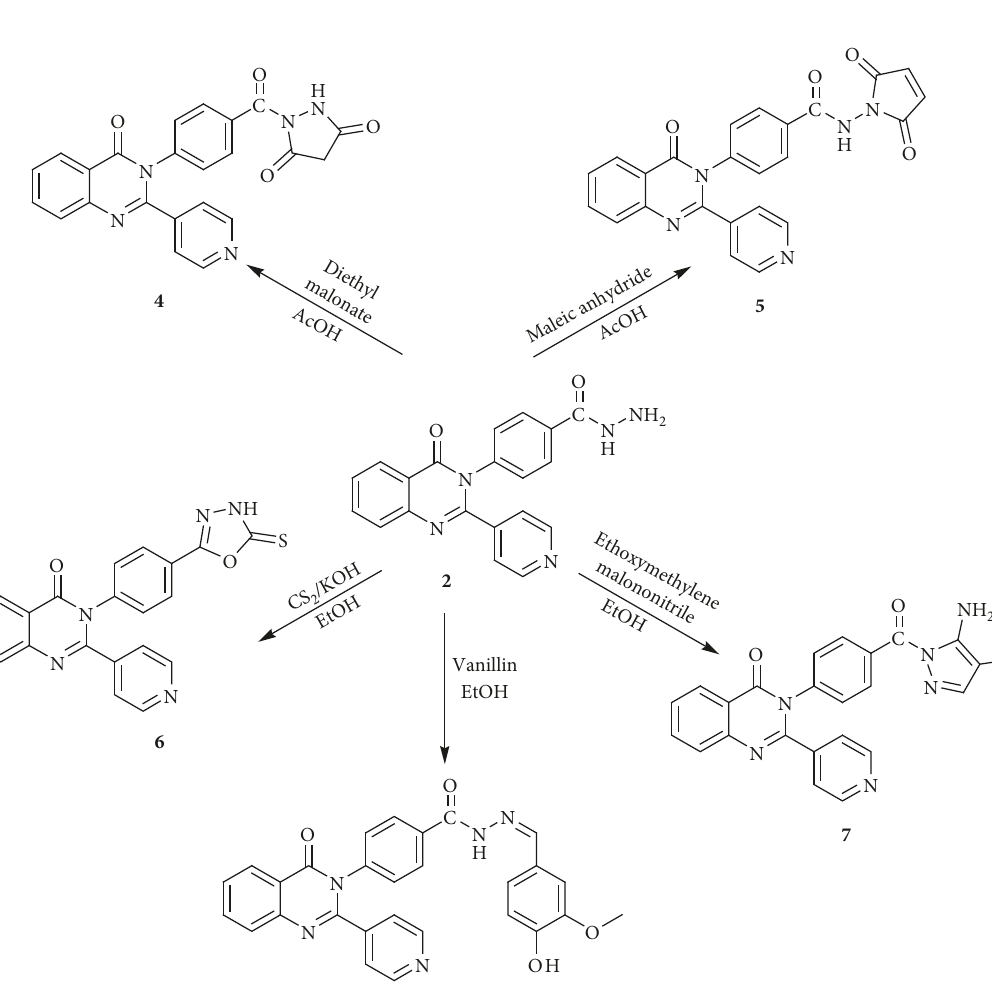
Scheme 1: Synthesis of compounds 2 and 3 .